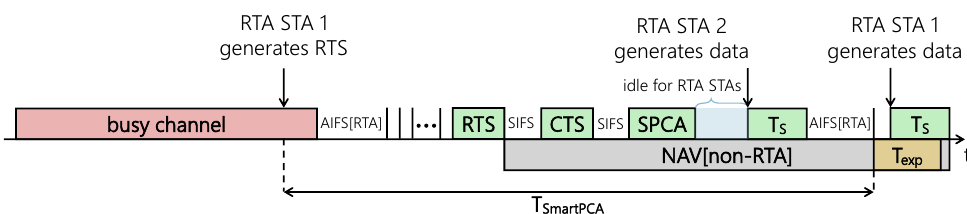
Figure 2. Transmission scheme of Smart